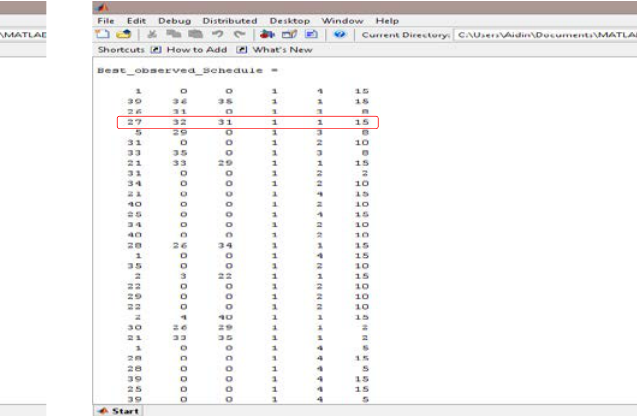
Fig. 12. The generated block diagonals obtained from the experiment 1 Fig. 13. Part-routes observed for the experiment 1